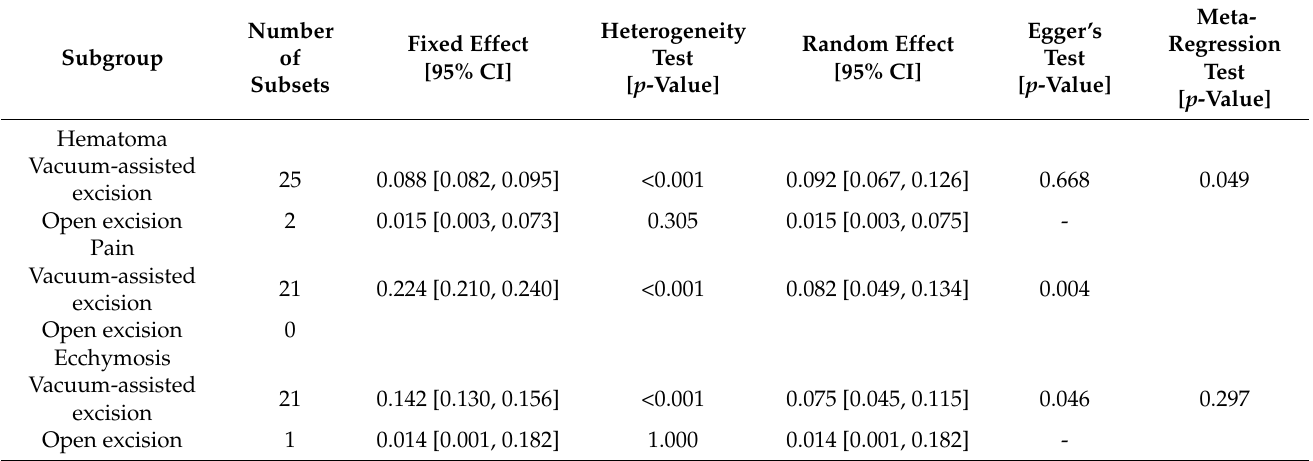
Table 4. The estimated complication rates after vacuum-assisted and open